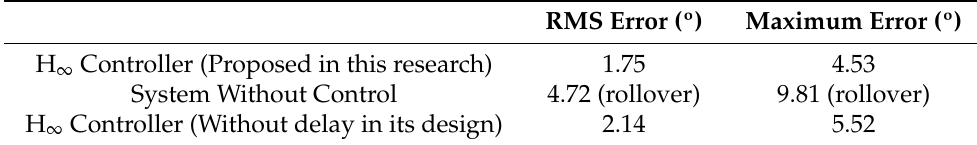
Table 6. RMS and maximum errors of roll angle for test